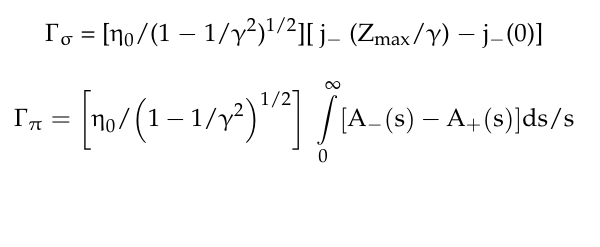
Figure 11. Same as in Figure 10, but for small impact parameters [82].